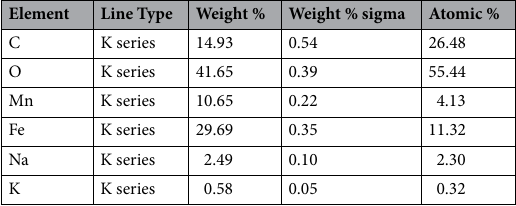
Table 6. EDX analysis of sample S4.